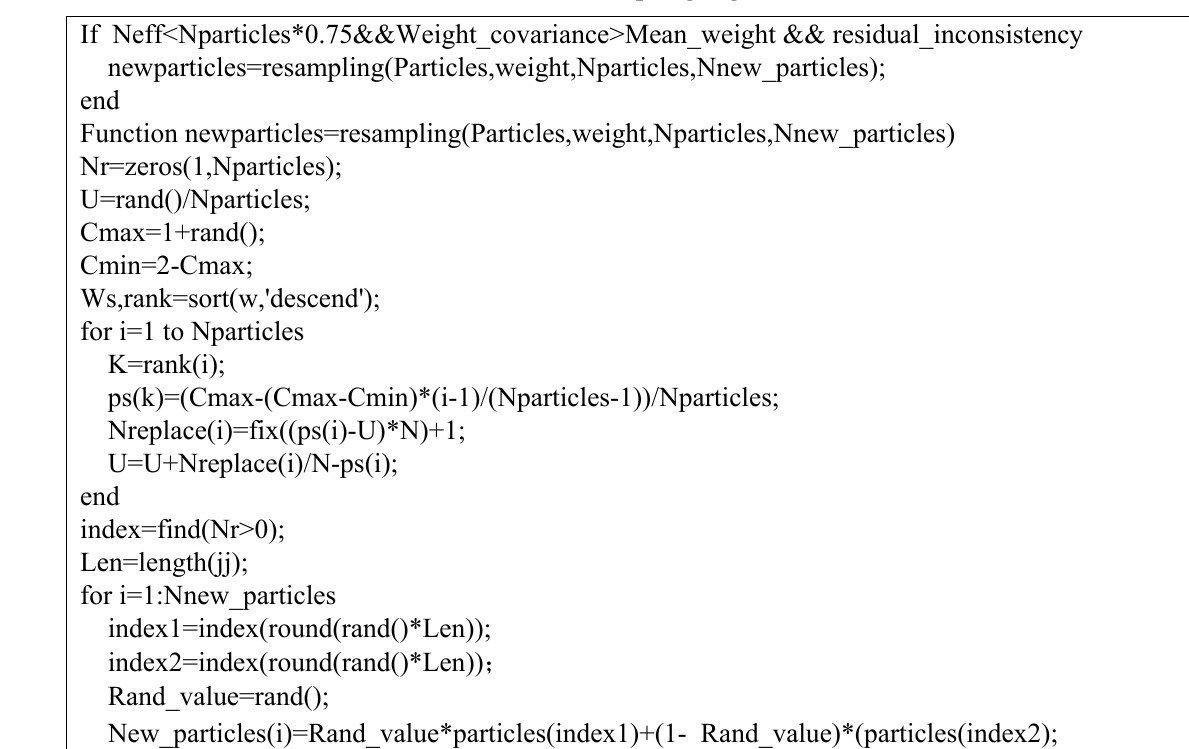
Table 1. Resampling